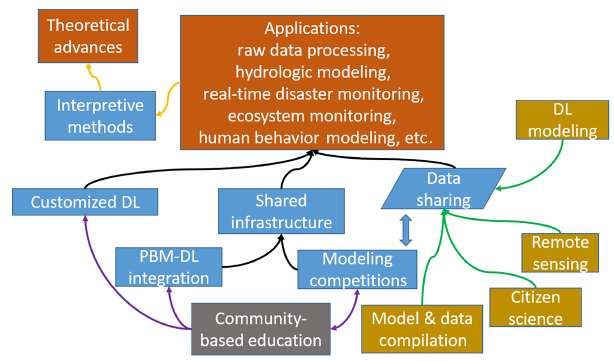
Figure 4. A roadmap toward DL-powered scientific discovery in hydrologic science. Data availability can be increased by (green ar- rows) collecting and compiling existing data, incorporating novel data sources such as those collected by citizen scientists, remote sensing, and modeling datasets. DL can be employed to predict data that are currently difficult to observe. The modeling competitions and the integration between PBM and DL will build an important shared computing and analytic infrastructure, which together with data sources, supports a wide range of hydrologic applications. In- terpretive methods should be attempted to extract knowledge from trained deep networks (orange arrows). Underpinning these activi- ties is the enhanced, community-based educational program for ma- chine learning in hydrology (purple arrows). However, these activi- ties, especially the modeling competitions, might in turn feed back into the educational